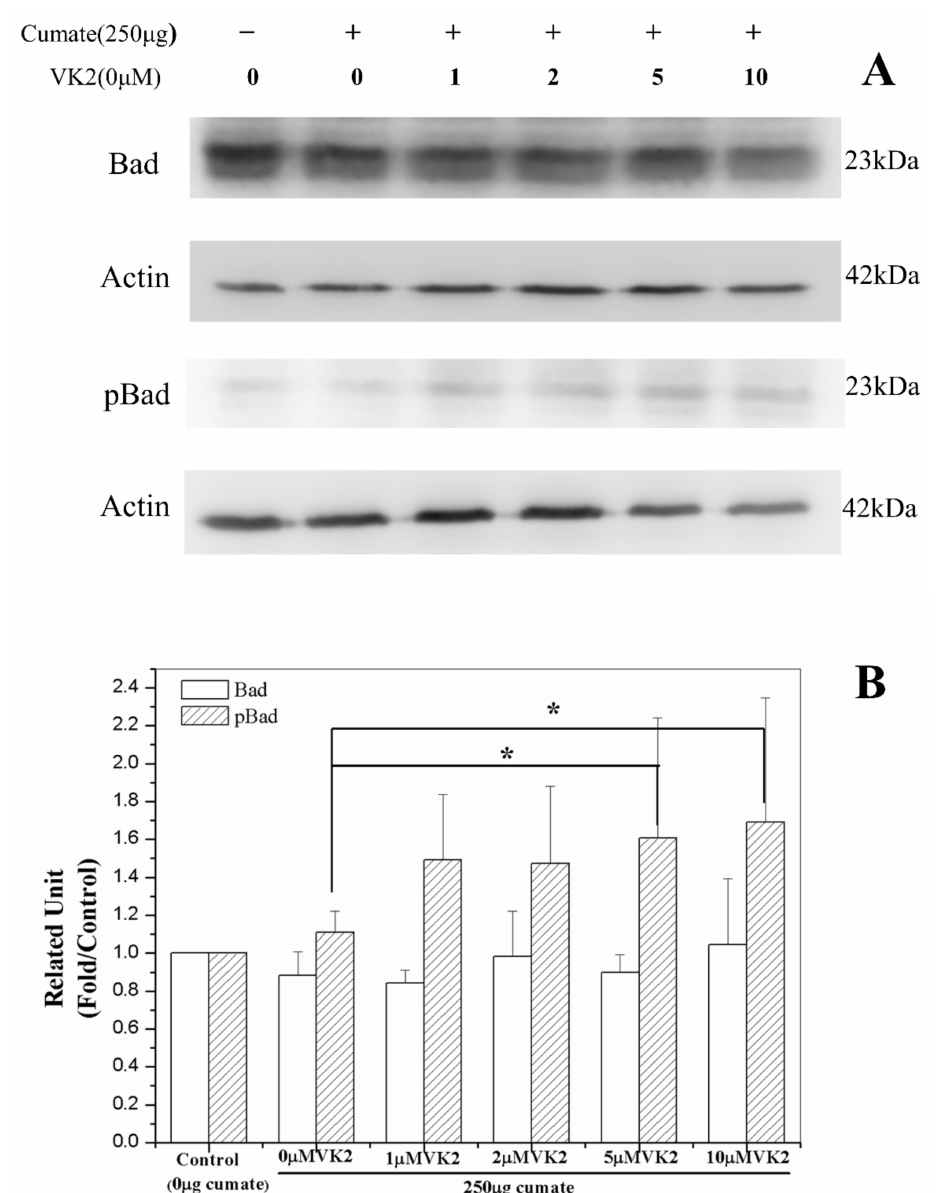
Figure 7. Effect of vitamin K2 on Bad phosphorylation. β -CTF/C6 cells were treated with 250 µ g cumate and 0–10 µ M of vitamin K2 (VK2) for 72 h. ( A ) Western blot analysis with a monoclonal antibody against Bad and p-Bad, and ( B ) relative Bad or p-Bad level/actin. Data are means ± SD. * p <